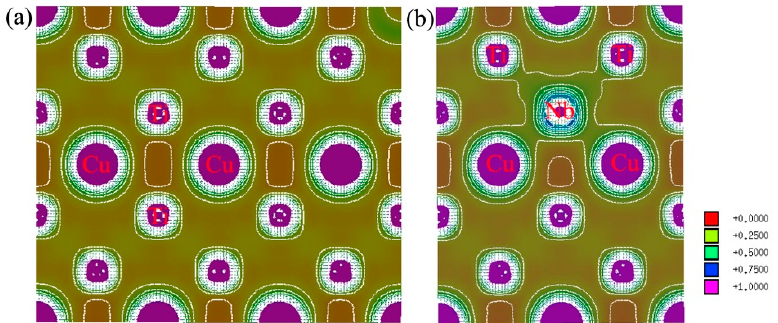
Figure 3. The planar projection of total charge density of the (110) plane from 0 e / Å 3 to 1 e / Å 3 for ( a ) Ti 2 Cu and ( b ) Ti 15 Cu 8 Nb.